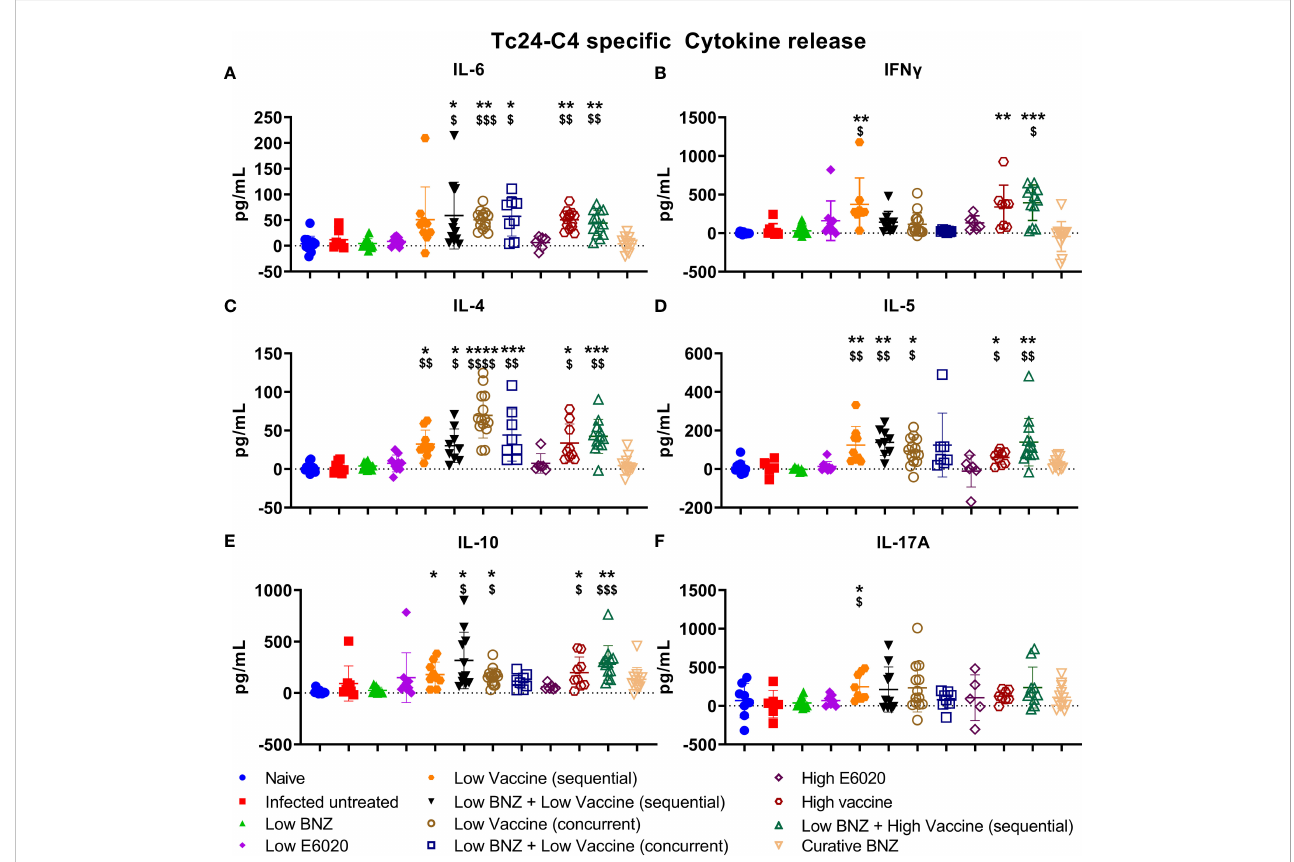
FIGURE 7 Antigen speci fi c TH1/TH2/TH17 cytokine release from splenocytes. Splenocytes were restimulated in vitro with recombinant Tc24-C4 protein or cRPMI alone (unstimulated) as described. Culture supernatants were harvested after 96 hours and stored at -80C until quanti fi cation of cytokines by Luminex assay. Data was analyzed for normality, then treatment groups were compared to controls using parametric or non-parametric ANOVA depending on normality. When comparing groups to the infected untreated control *, p ≤ 0.05; **, p ≤ 0.01; ***, p ≤ 0.001; ****, p ≤ 0.0001. When comparing groups to E6020 only treatment $, p ≤ 0.05. $$, p ≤ 0.01; $$$, p ≤ 0.001; $$$$, p ≤